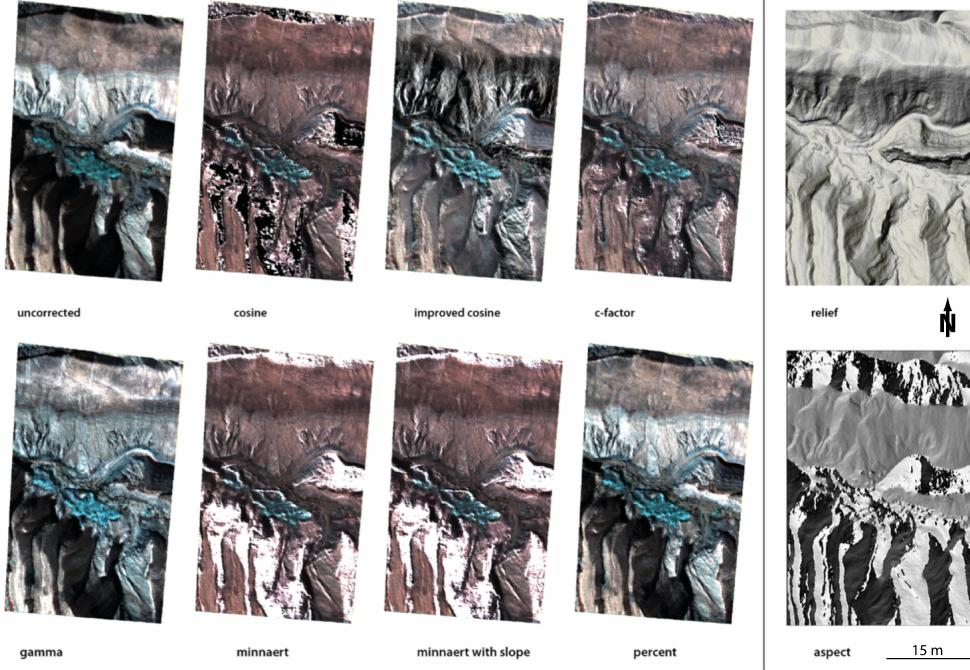
Figure 5. Comparison of topographic correction algorithms for drone-borne data under extreme illumination conditions (Sylvester mine test site, solar elevation angle: